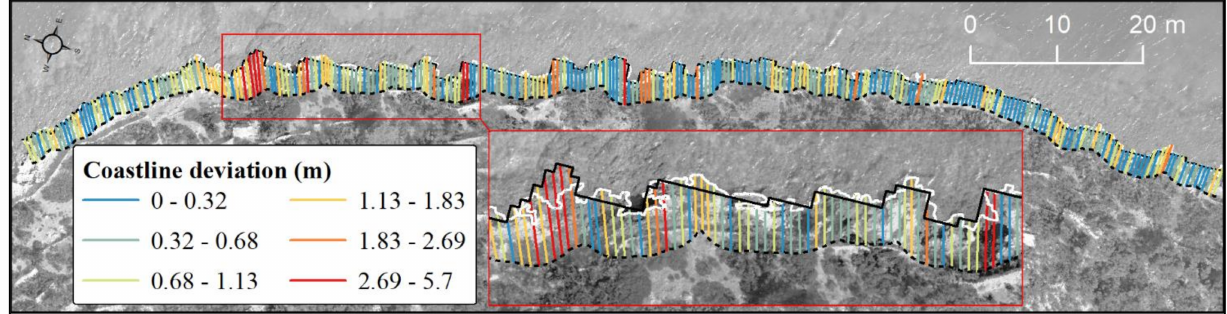
Figure 11. Coastline deviation between evaluated CET-WW and reference CET-UAV coastlines calculated by